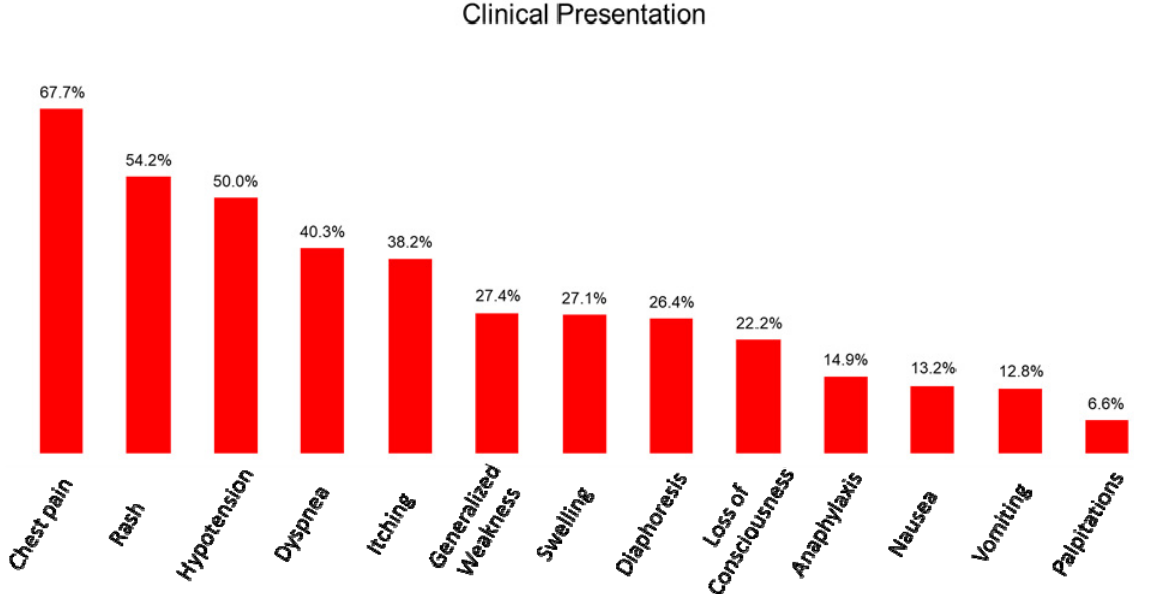
Figure 2. Clinical presentation of patients with Kounis syndrome according to symptom preva- lence.